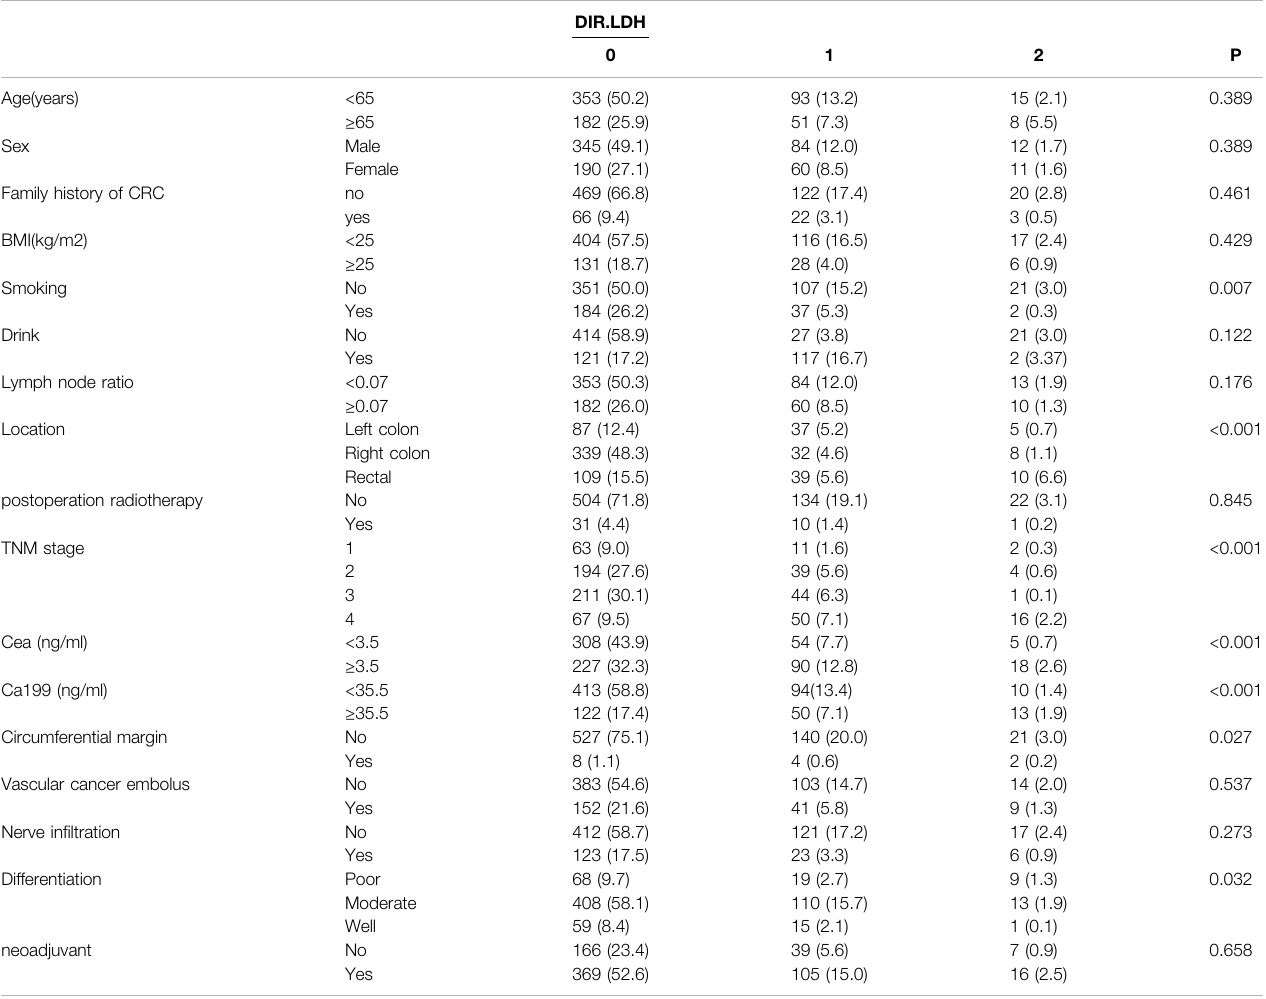
TABLE 1 | Demographic and tumor characteristics of colorectal cancer